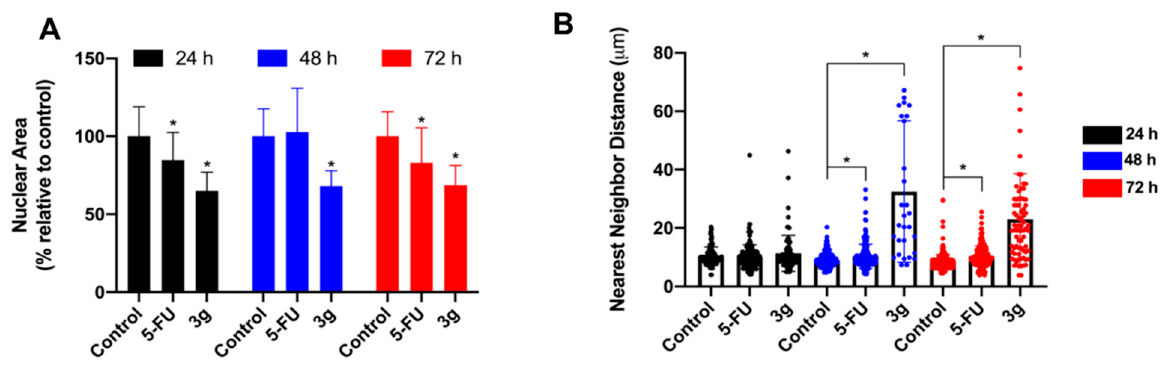
Figure 3. ( A ) T47D nuclear area of untreated cells (control) and cells treated with 5-fluorouracil (5-FU) and 3g at 20 µM, incubated 24, 48 and 72 h; ( B ) nearest neighbor analysis of T47-D cells with the same conditions referred previously. Data are mean ± SD (A) or individual points ± SD (B) and represent at least two experiments. * p < 0.05 compared to control.